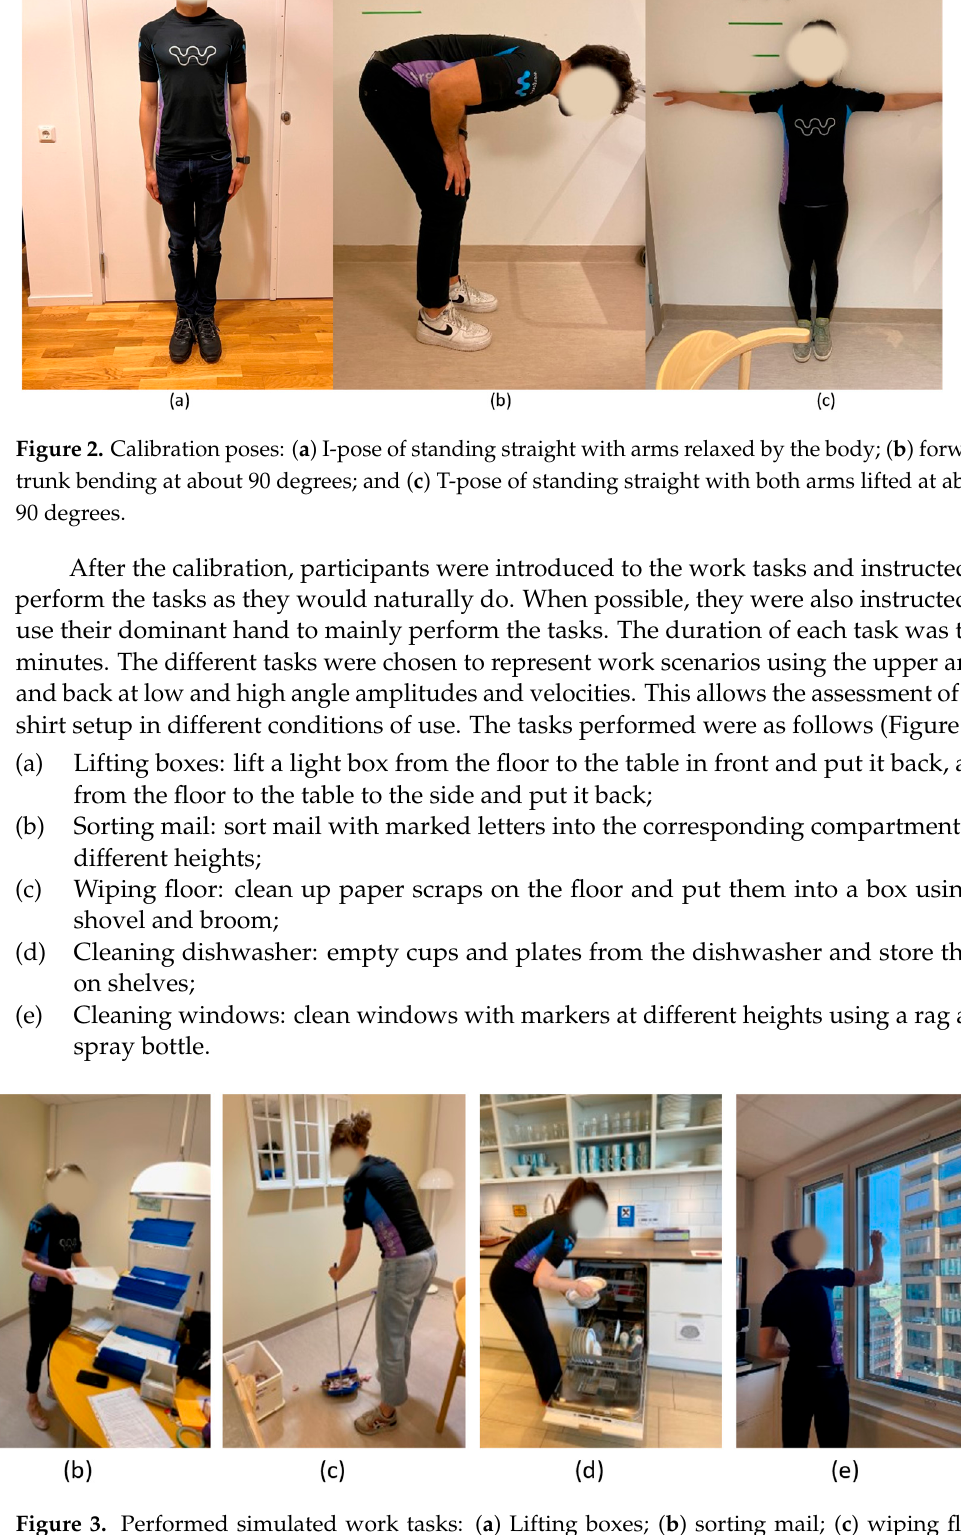
Figure 3. Performed simulated work tasks: ( a ) Lifting boxes; ( b ) sorting mail; ( c ) wiping floor; ( d ) cleaning dishwasher; and ( e ) cleaning windows.